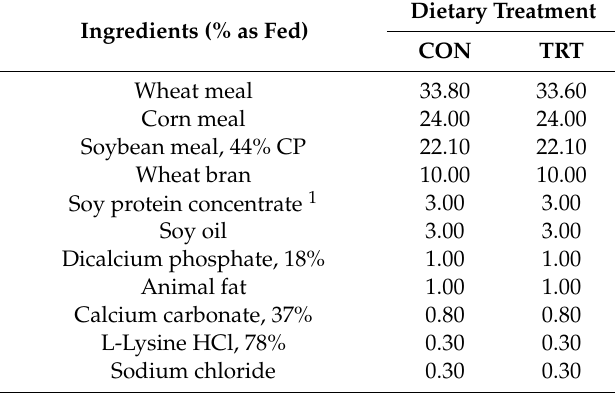
Table 1. Feed ingredients and nutrient composition of the post-weaning experimental